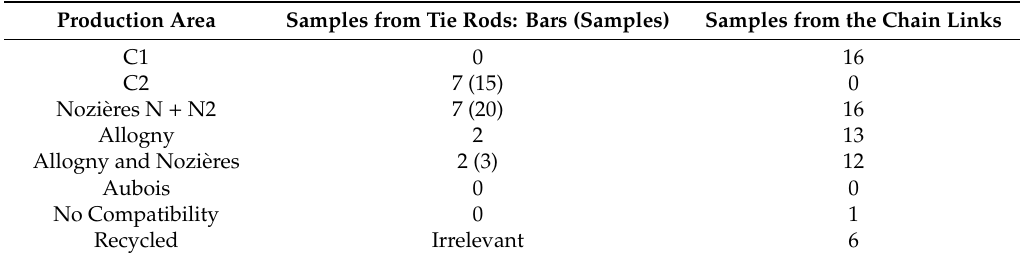
Table 7. Distribution of provenances regarding the type of iron